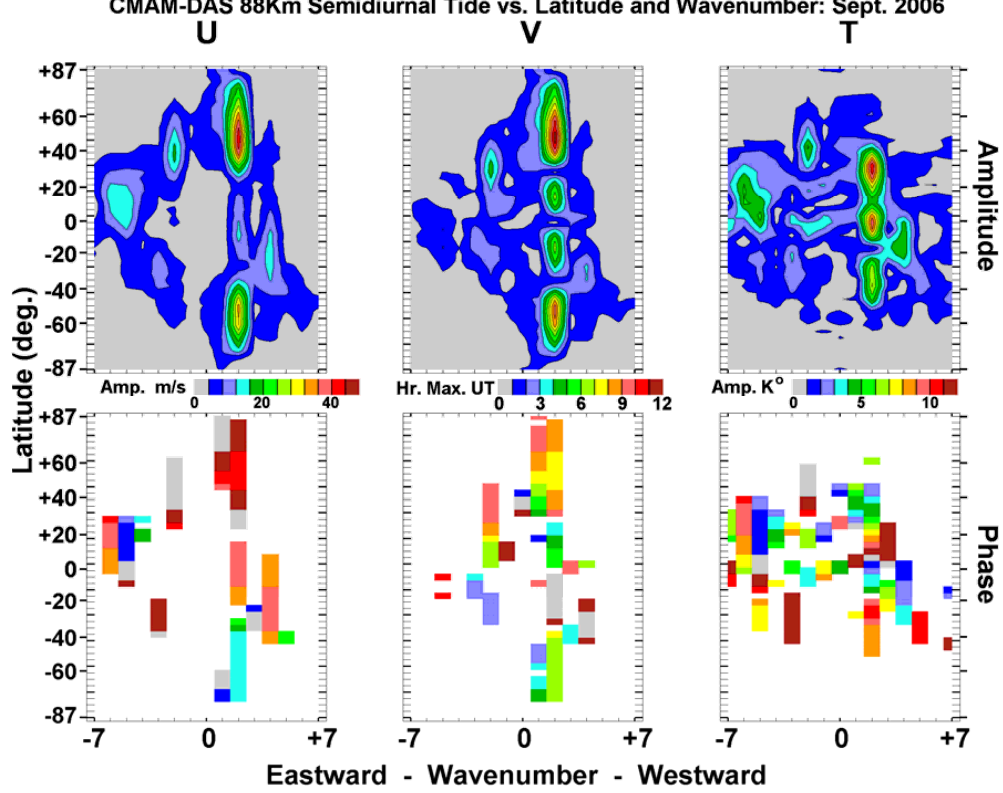
Fig. 4. Contour-plots of amplitudes and phases of the semidiurnal tide [meridional and zonal wind components, and temperature] as functions of wave-number and latitude: Data for September 2006 from the model CMAM-DAS have been used, and the results for 88 km are shown.